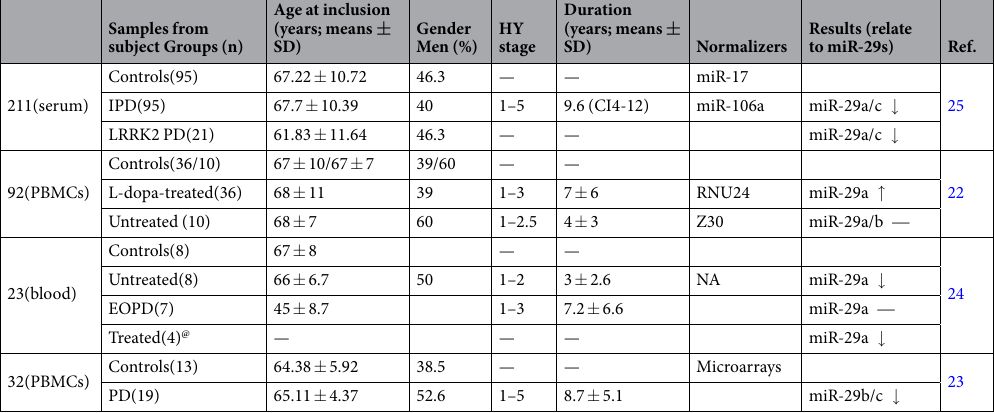
Table 3. Summary of previous studies of miR-29s in patients with PD. Abbreviations: LRRK2 PD = Patients with LRRK2-associated Parkinson’s disease carrying the heterozygous G2019S mutation; EOPD = Early-onset Parkinson’s disease; HY stage = Hoehn & Yahr stage; PBMCs = Peripheral blood mononuclear cells. NA = Not available. @ Selected previously untreated PD patients after 97 ( ± 39) days of the levodopa/carbidopa